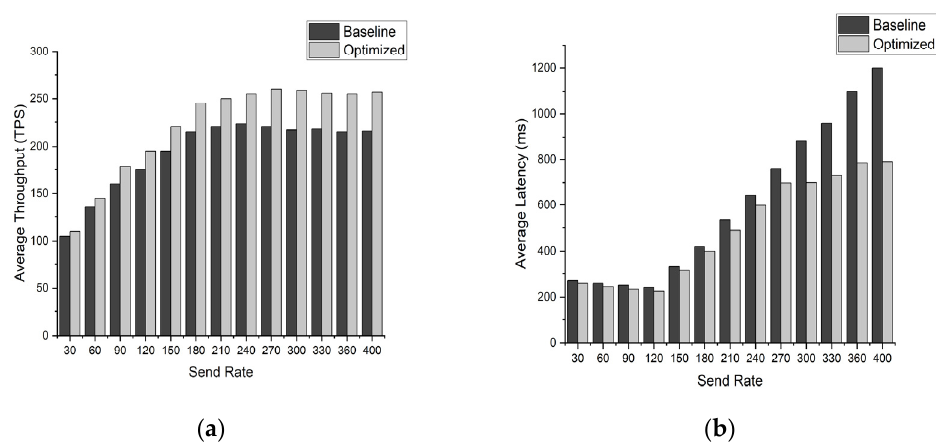
Figure 9. Average transaction throughput ( a ) and latency ( b ) with one TSO and five DSO.